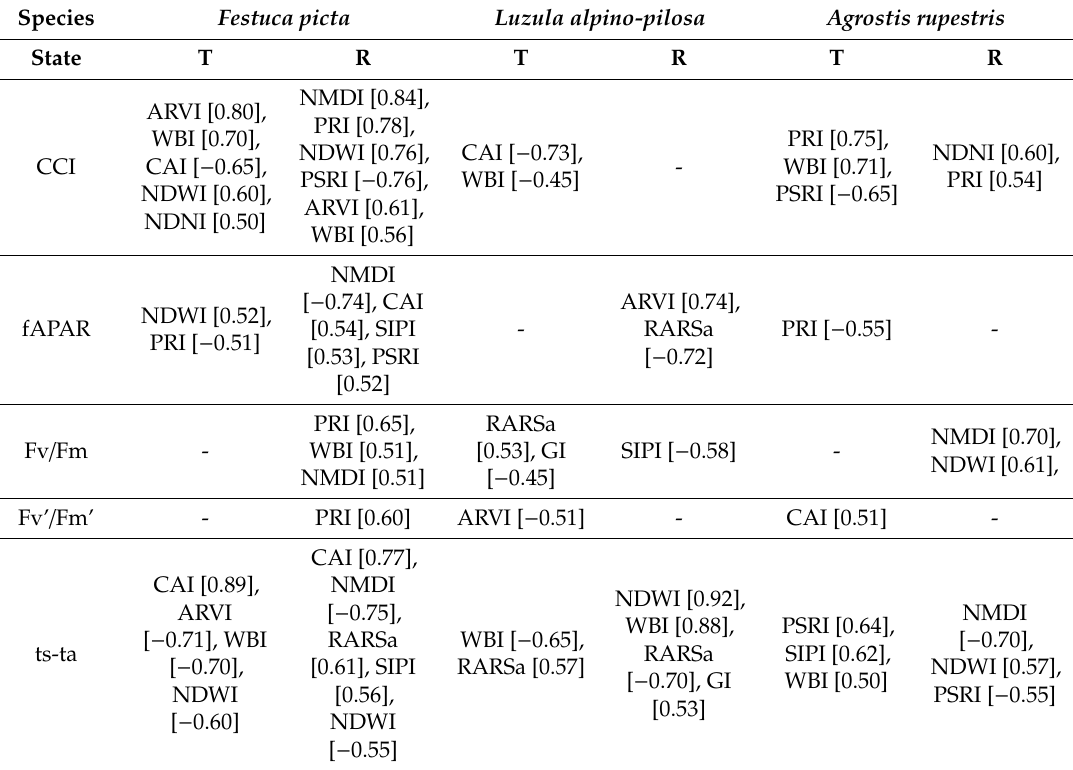
Table 3. Correlations between remote sensing indices and biometrical variables. Explanations: T—trampled, R—reference. Species Festuca picta Luzula alpino-pilosa Agrostis